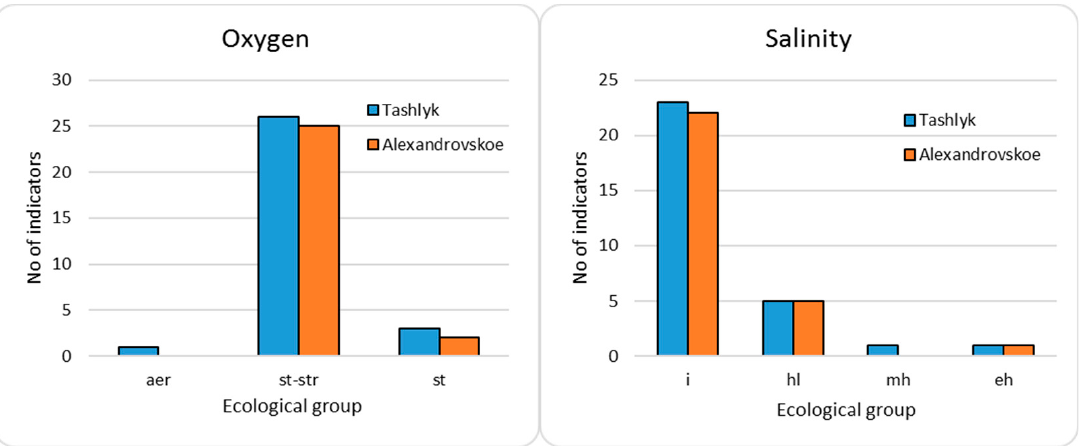
Figure 7. Distribution of indicators of oxygen saturation and water salinity for phytoplankton communities in two reservoirs of Southern Bug River, Tashlyk and Alexandrovskoye. Ecological groups on the x -axis are placed in order of increasing indicator variable value. Abbreviations of ecological groups are given in Table 3.